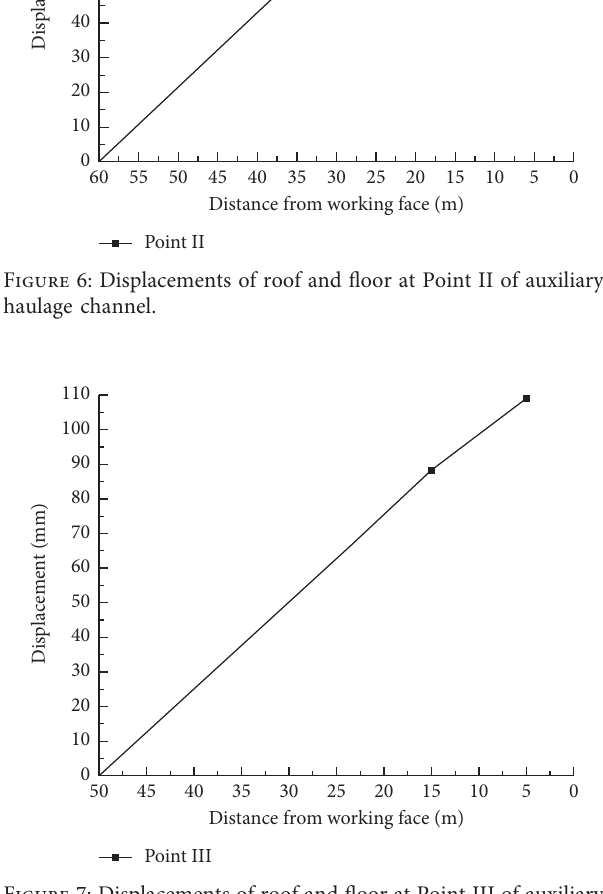
Figure 5: Displacements of roof and floor at Point I of auxiliary haulage channel.